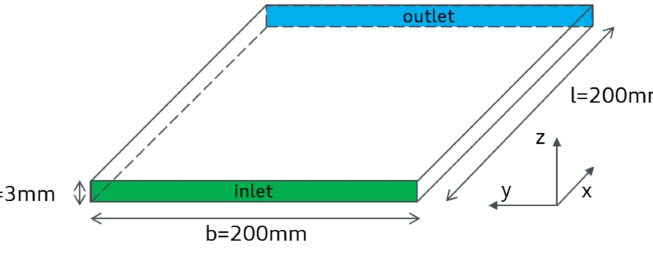
Figure 2. Simulation model used for verification with inlet and outlet boundary